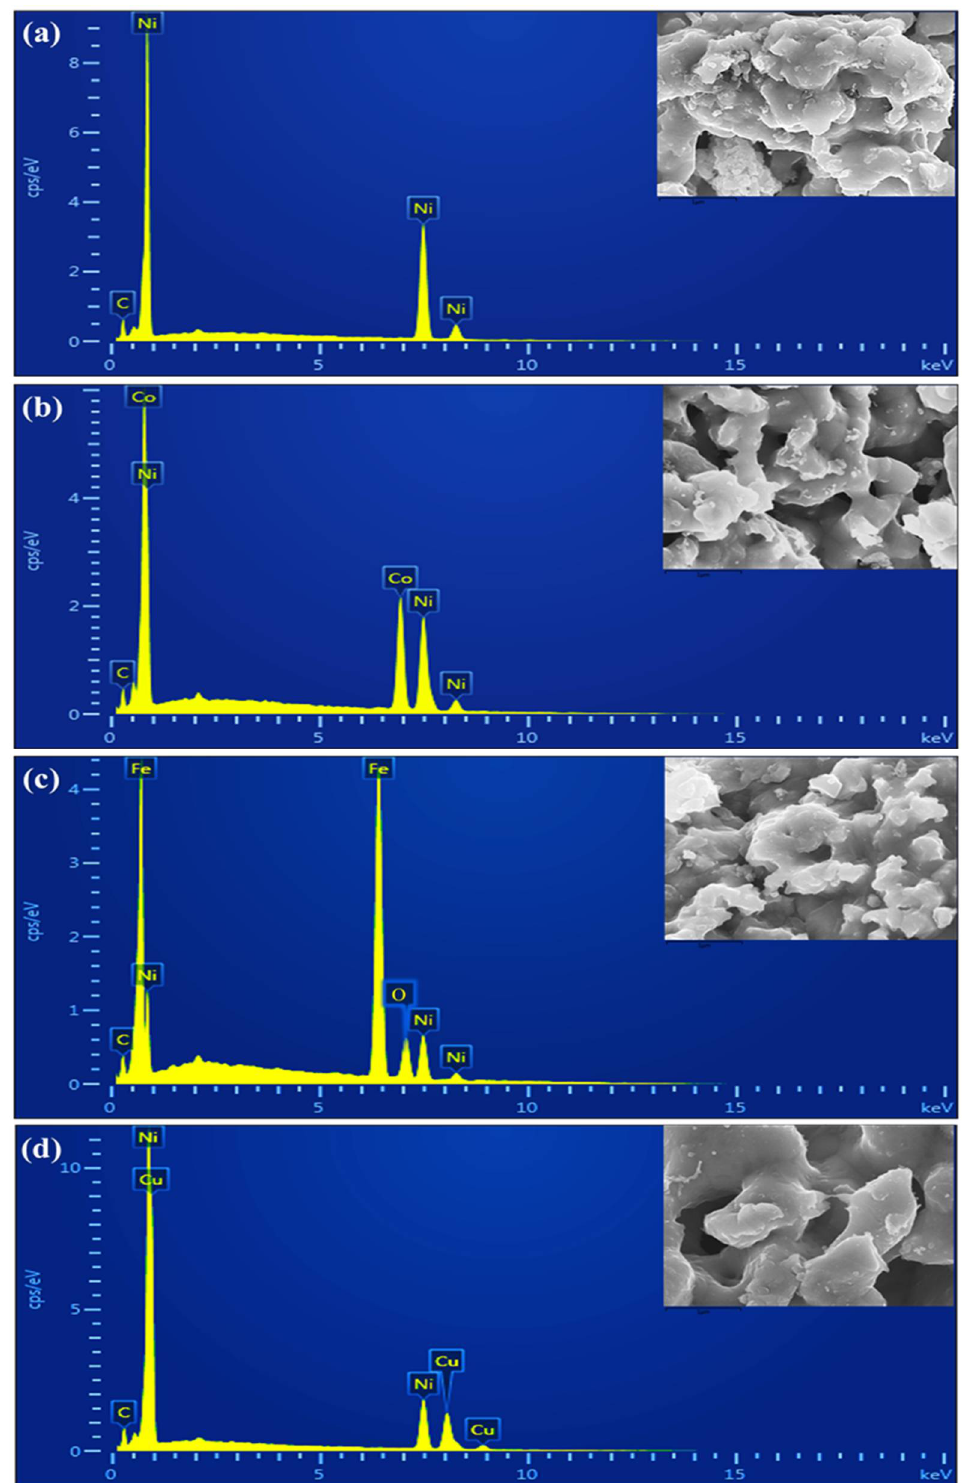
Figure 7. EDX spectra of the reduced samples: ( a ) Ni, ( b ) Ni-Co, ( c ) Ni-Fe, and ( d ) Ni-Cu.